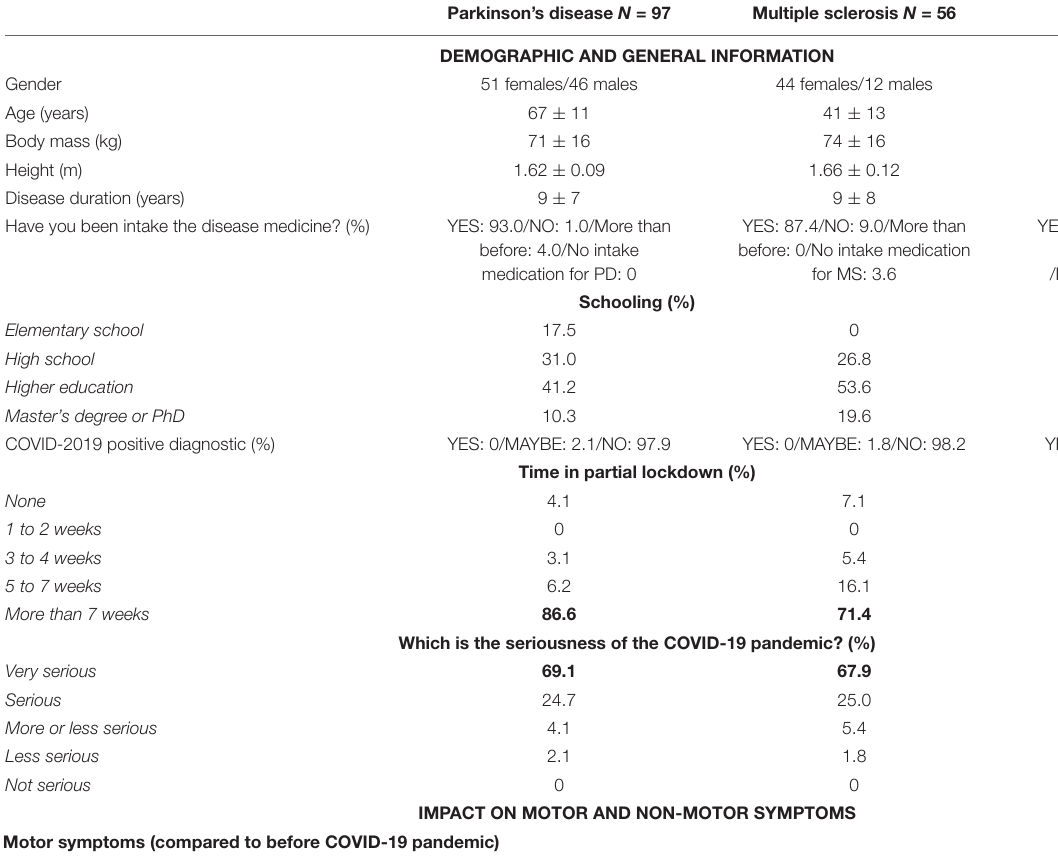
TABLE 1 | Demographic details, perceived impact on motor and non-motor symptoms, and implications of COVID-19 on quality of life, level of physical activity, anxiety and depression, and sleep quality in people with Parkinson’s disease (PD) and multiple sclerosis. Parkinson’s disease N = 97 Multiple sclerosis N =